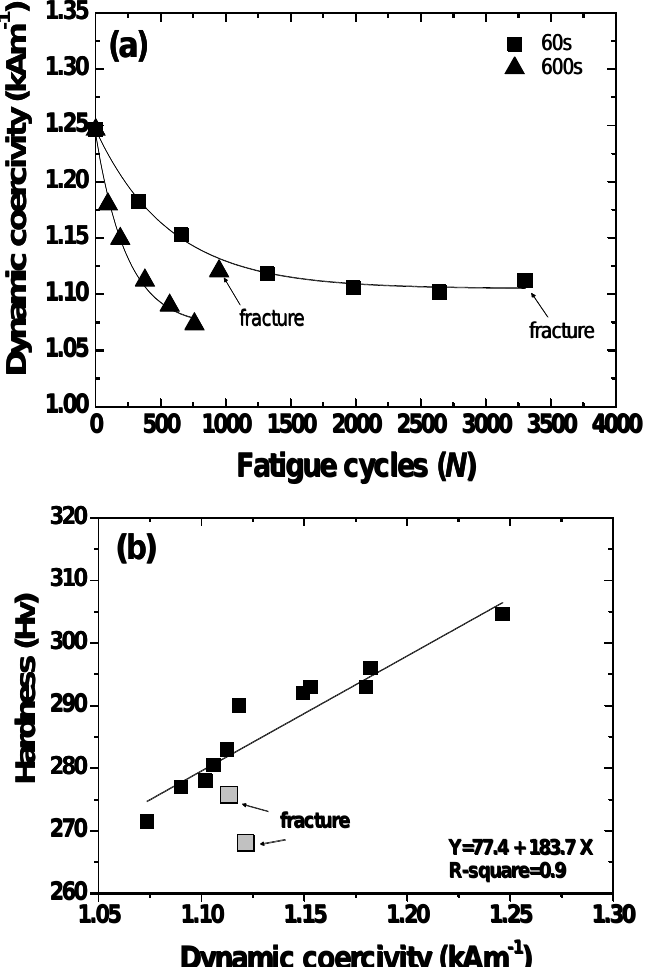
Figure 1. Variation in dynamic coercivity and Vicker’s hardness; ( a ) dynamic coercivity with fatigue cycles and ( b ) correlation between hardness and dynamic coercivity.